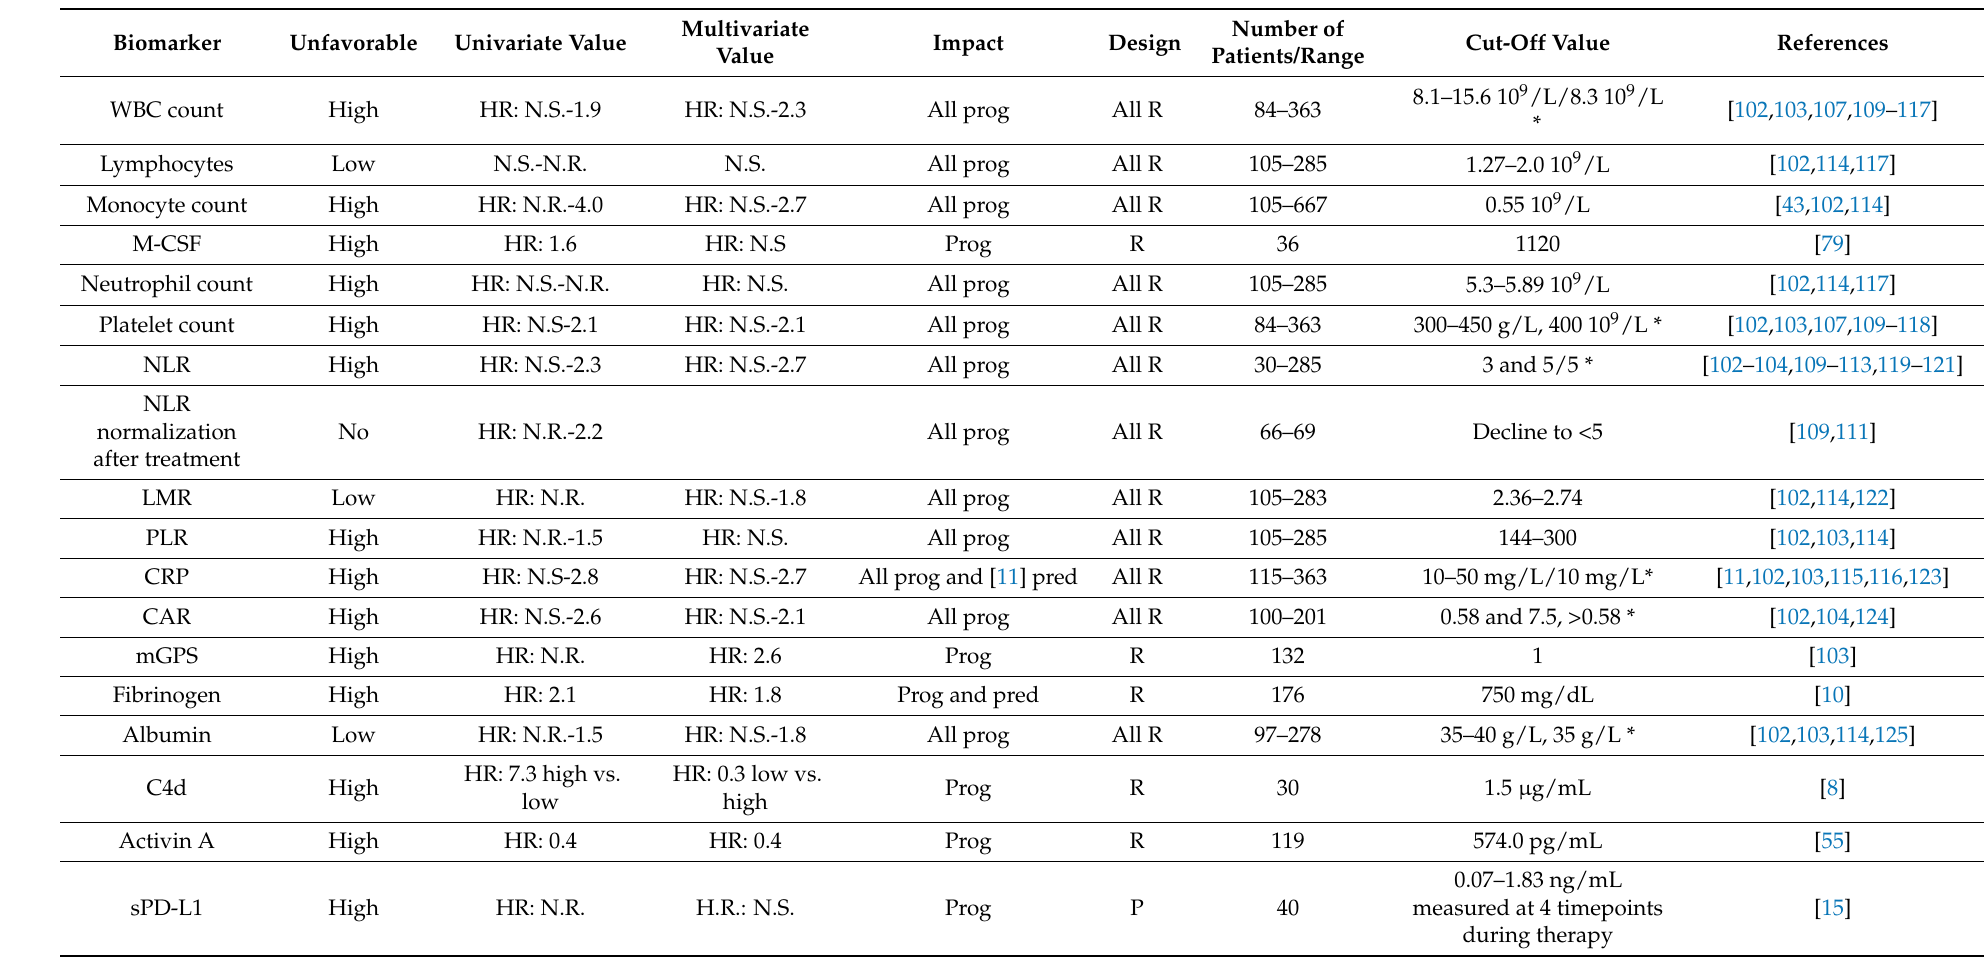
Table 2. Potential Systemic Inflammatory